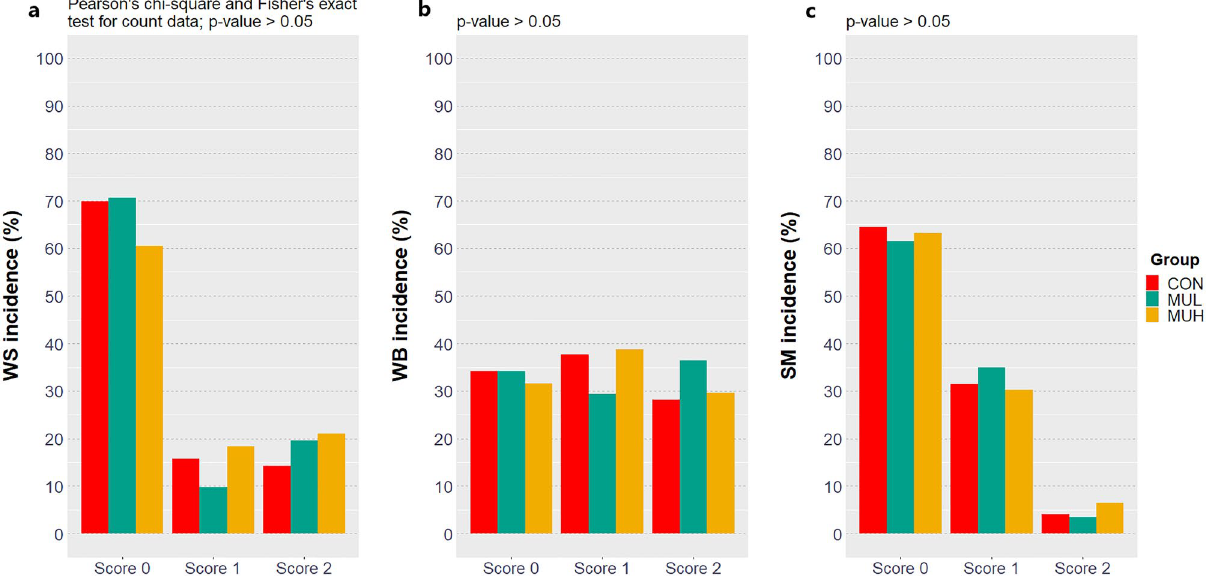
Figure 3. WS ( A ), WB ( B ), and SM ( C ) incidence and severity (score 0, no abnormalities; score 1, moderate degree; score 2, severe degree) of CON, MUL, and MUH at slaughter (42 d). WS, WB, and SM were macroscopically measured on a representative sample of breast fillets ( n = 146, 143, and 152 for CON, MUL, and MUH, respectively) after chilling, deboning, and skin removal.